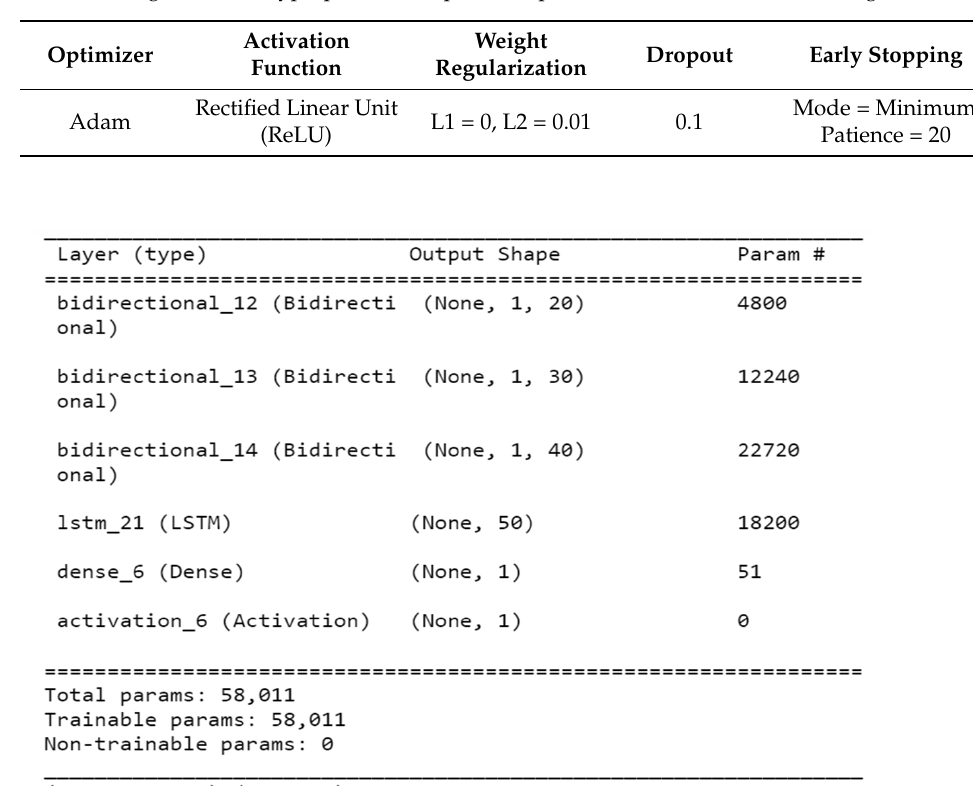
Figure 9. The stacked BiLSTM model development layers are shown during the modelling process.